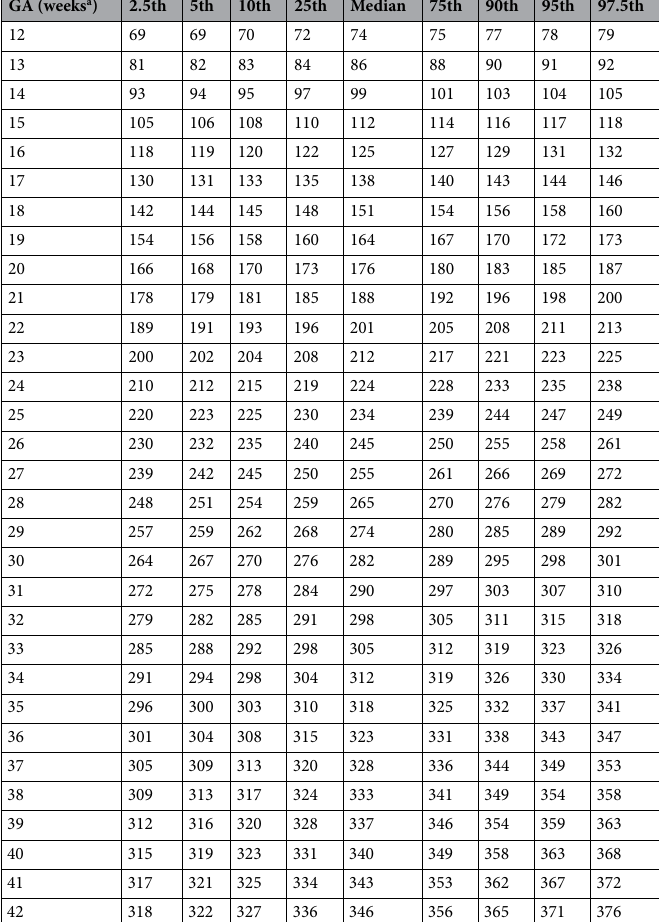
Table 5. Estimated head circumference (HC) in mm by gestational age (GA) for males and females, percentiles. a GA expressed as completed gestational weeks, e.g. 12 weeks corresponds to 12 + 0 weeks or 84 gestational